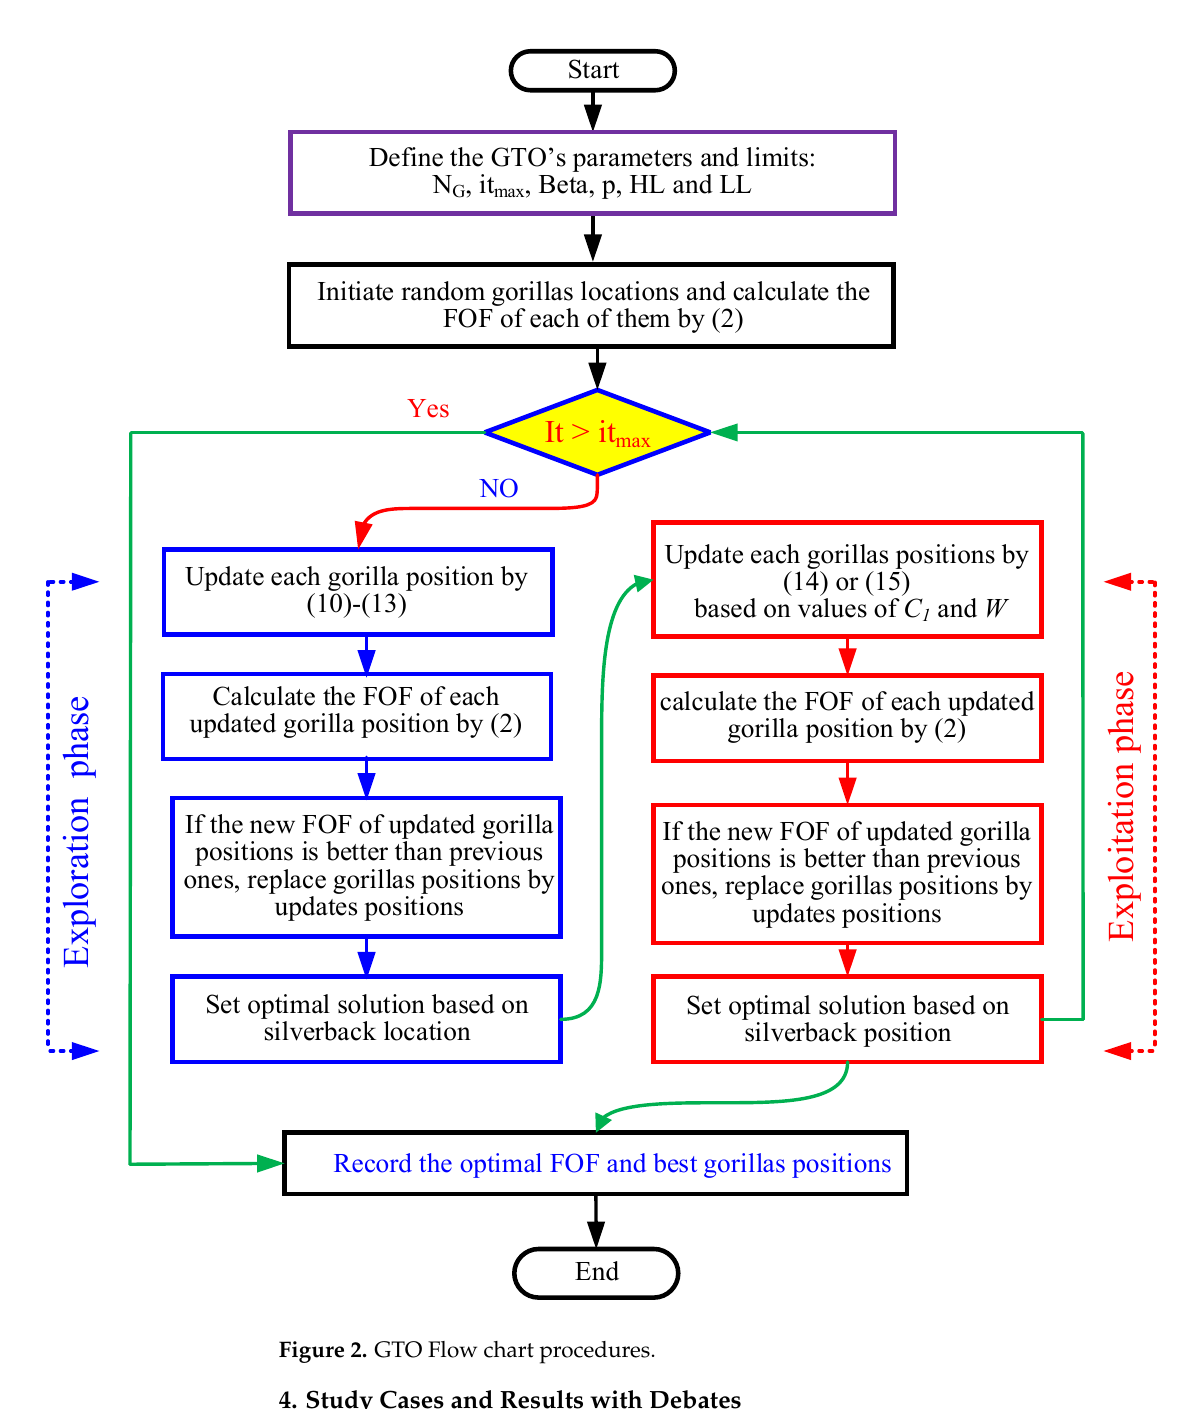
Figure 2. GTO Flow chart procedures.